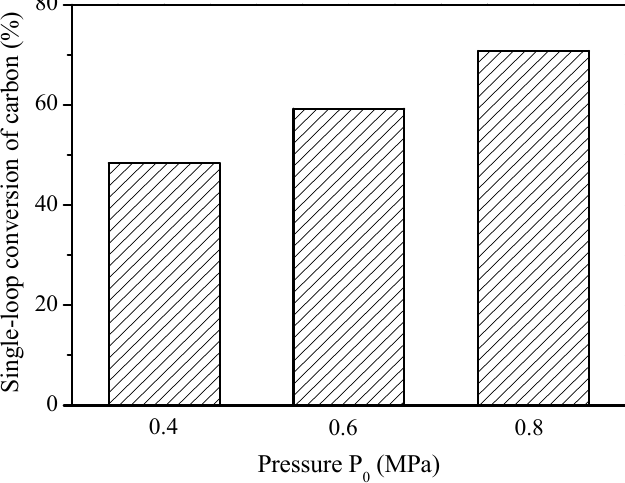
Figure 16. Influence of operating pressure on the single-loop carbon conversion in the fuel reactor.